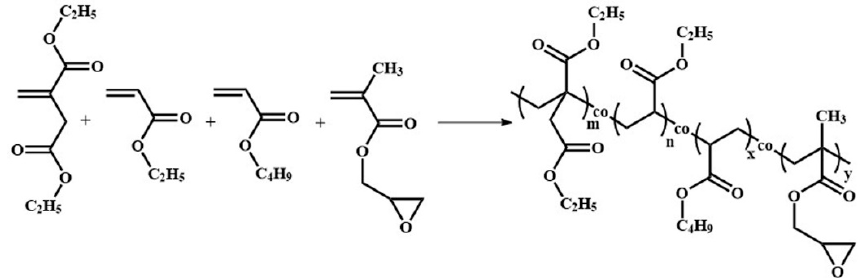
Figure 2. Reaction formula of PDEBEG by redox-initiated emulsion polymerization.